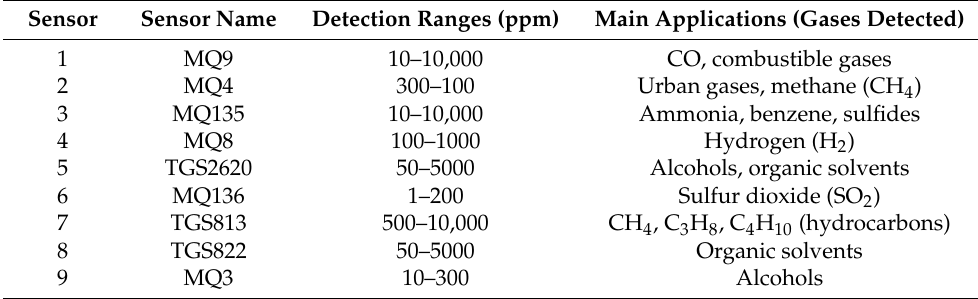
Table 1. The sensor types, gas detection ranges, and known chemical sensitivity of tin oxide MOS sensors within the MAU-9 electronic nose sensor